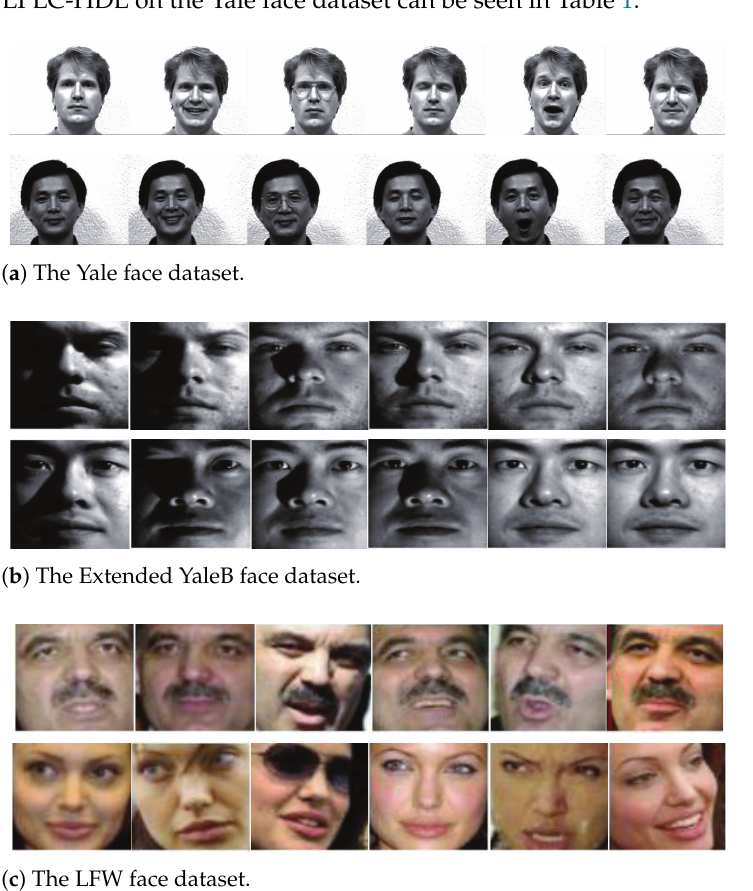
Figure 2. The example images from the face